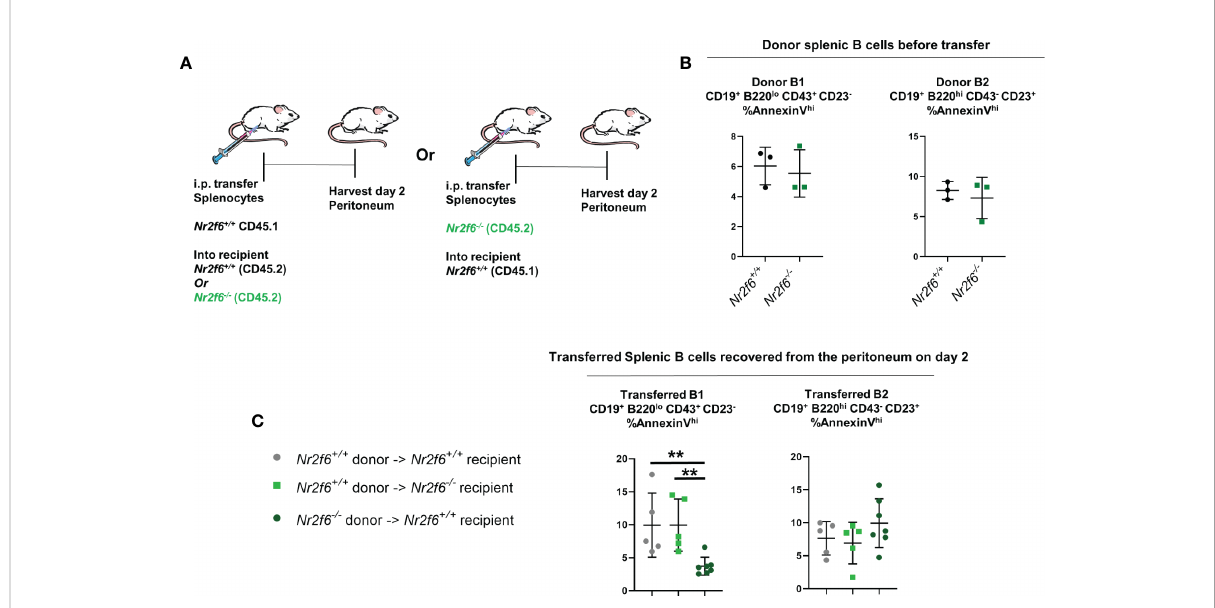
FIGURE 8 Transfer of Nr2f6 -suf fi cient or -de fi cient splenocytes into both Nr2f6 +/+ and Nr2f6 -/- recipients. (A) Experimental scheme for adoptive cell transfer. (B) Frequency of AnnexinV + cells from the indicated donor splenocytes measured prior to adoptive cell transfer. (C) AnnexinV + frequency on transferred B1 and B2 cells, two days after transfer. Data shown are from three independent experiments with two or more mice of each genotype per experiment. Statistical signi fi cance was determined using a two-tailed student t-test, signi fi cant p-values are displayed as